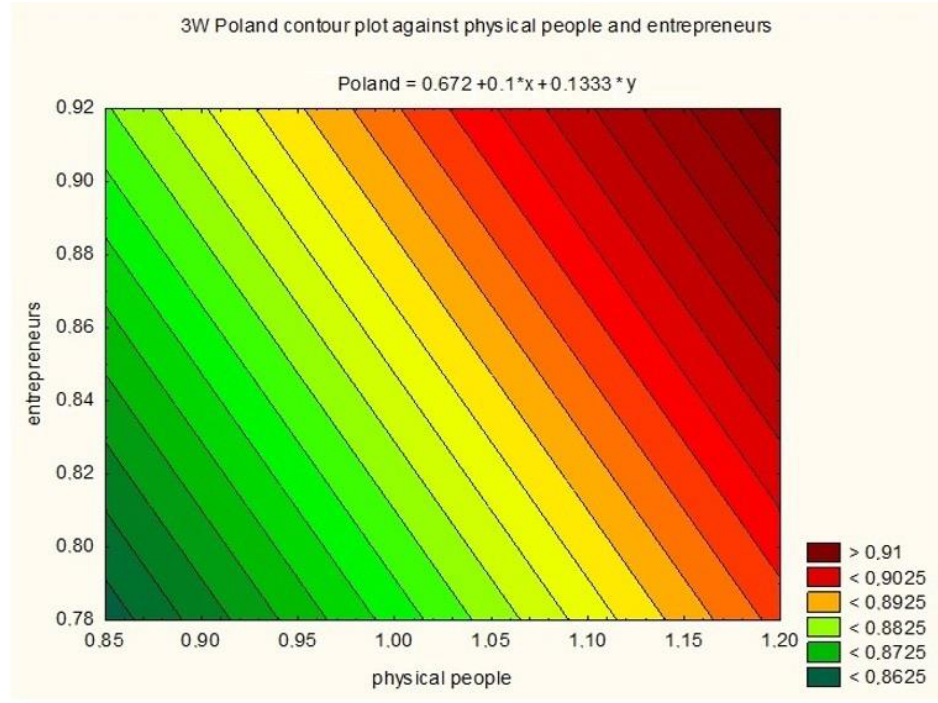
Figure 22. Contour chart verifying Poland’s chances of meeting the hydrogen